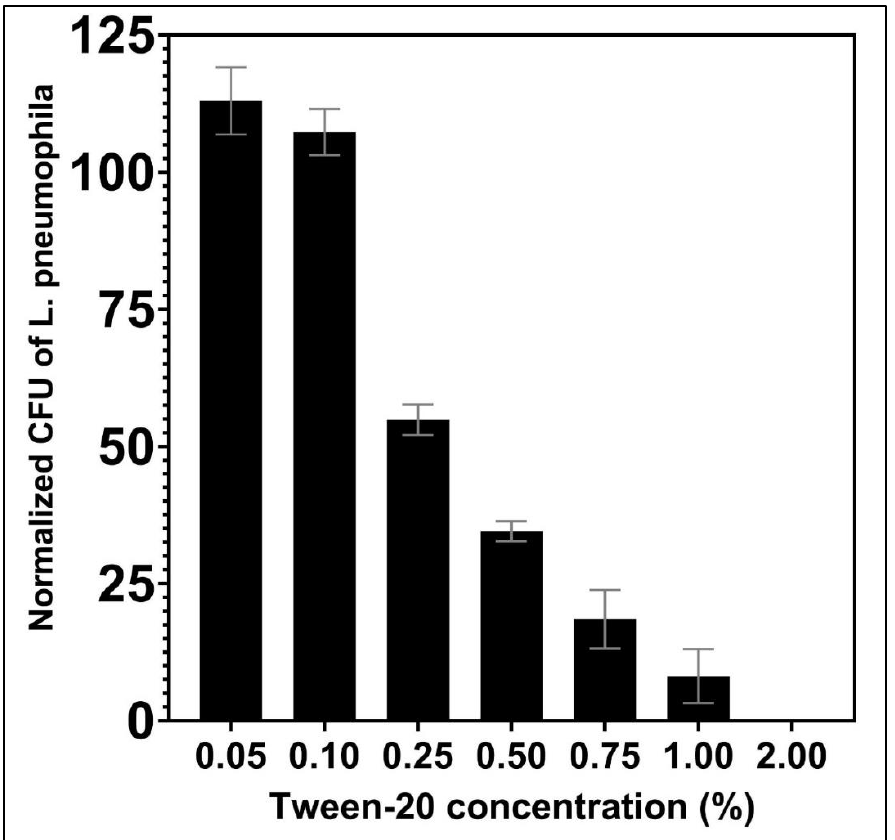
Figure A2. Colony counts of L. pneumophila exposed to various concentrations of Tween-20 for 5 min and plated on BCYE ( n = 3). Count values were normalized against the control PBS exposure without detergent. Errors bars indicate standard